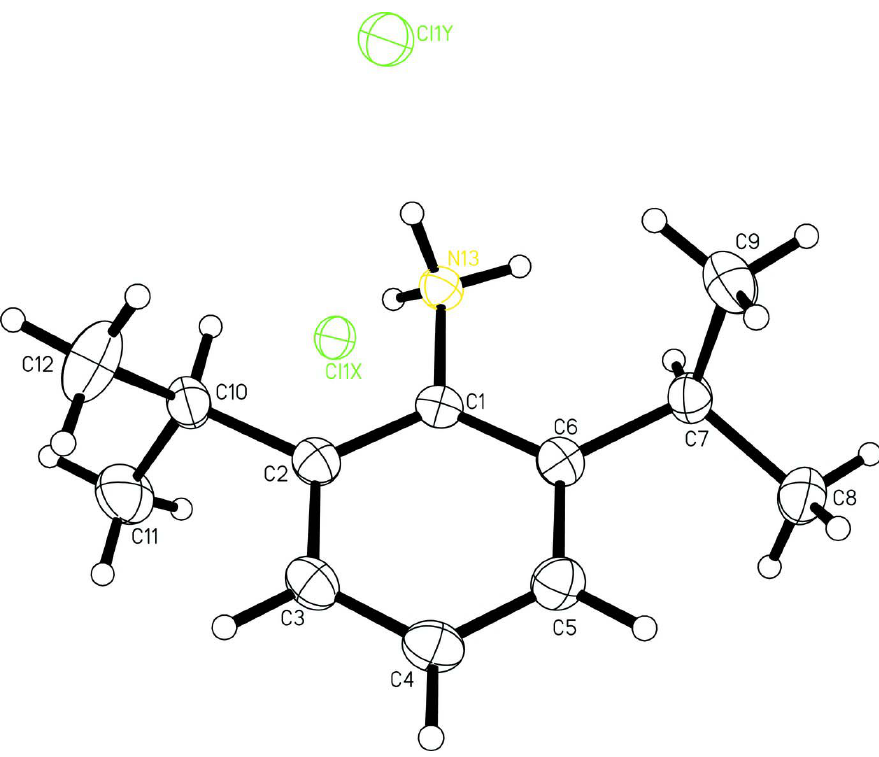
Figure 1 View of the constituents of (I), showing the atom-labeling scheme and displacement ellipsoids drawn at the 30% probability level. H atoms are represented by circles of arbitrary